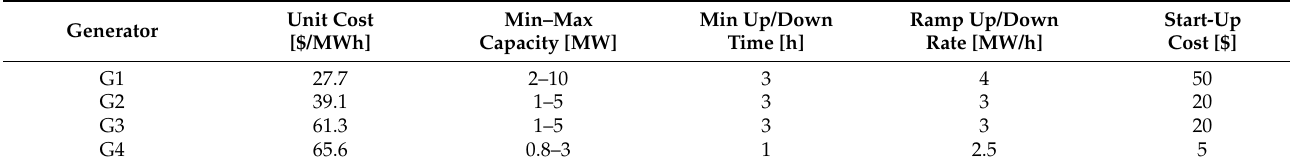
Table 1. Characteristics of thermal units.